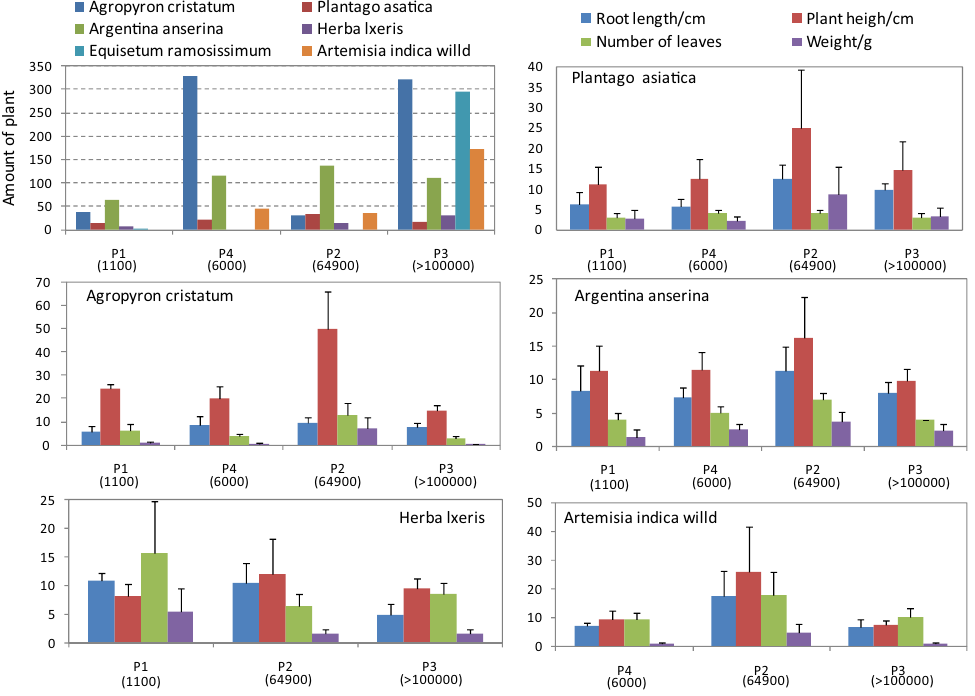
Figure 2. Plant community distribution ( a ) and apparent characters of Agropyron cristatum, Plantago asiatica, Argentina anserina, Artemisia indica willd and Herba lxeris ( b – f